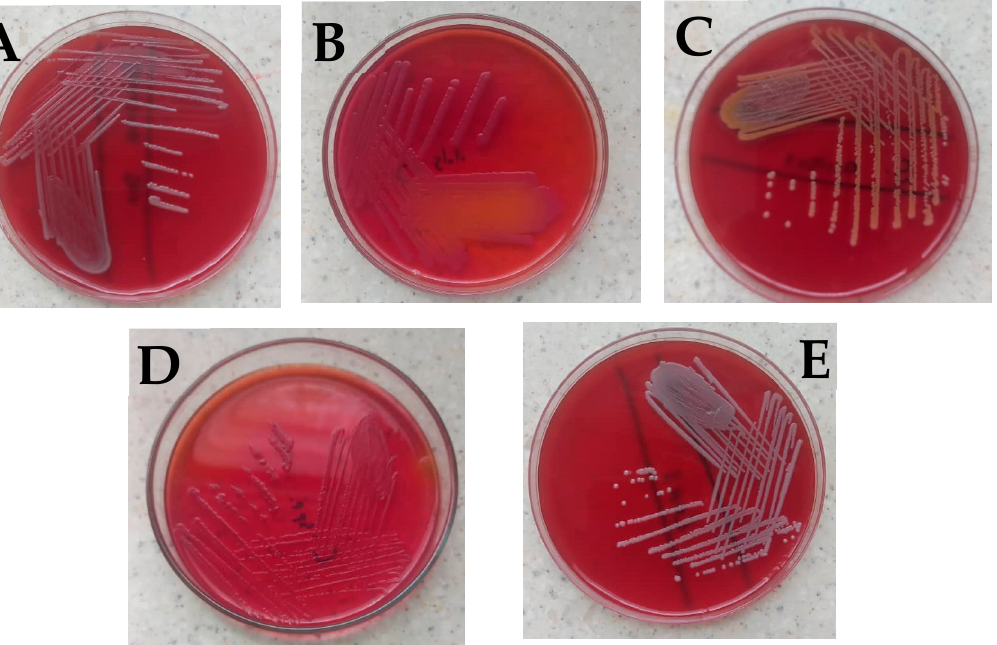
Figure 1. Bacterial isolates observed in the study. ( A ) Bacillus cereus on blood agar showing gray round colonies, with varying morphologies of low convex to convex, entire, and were mostly rough, granular, or ground glass in appearance. ( B ) Citrobacter freundii on MacConkey which showed small pink smooth colonies with partial lactose fermentation ( C ) Staphylococcus aureus with golden yellow colonies on blood agar ( D ) Citrobacter spp. on MacConkey which appeared as non-lactose fermenter up to 24 h; however, after 48 h colonies turned light pink, and ( E ) coagulase-negative Staphylococci showing small whitish round colonies on blood agar which was identified to be Staphylococcus hominis